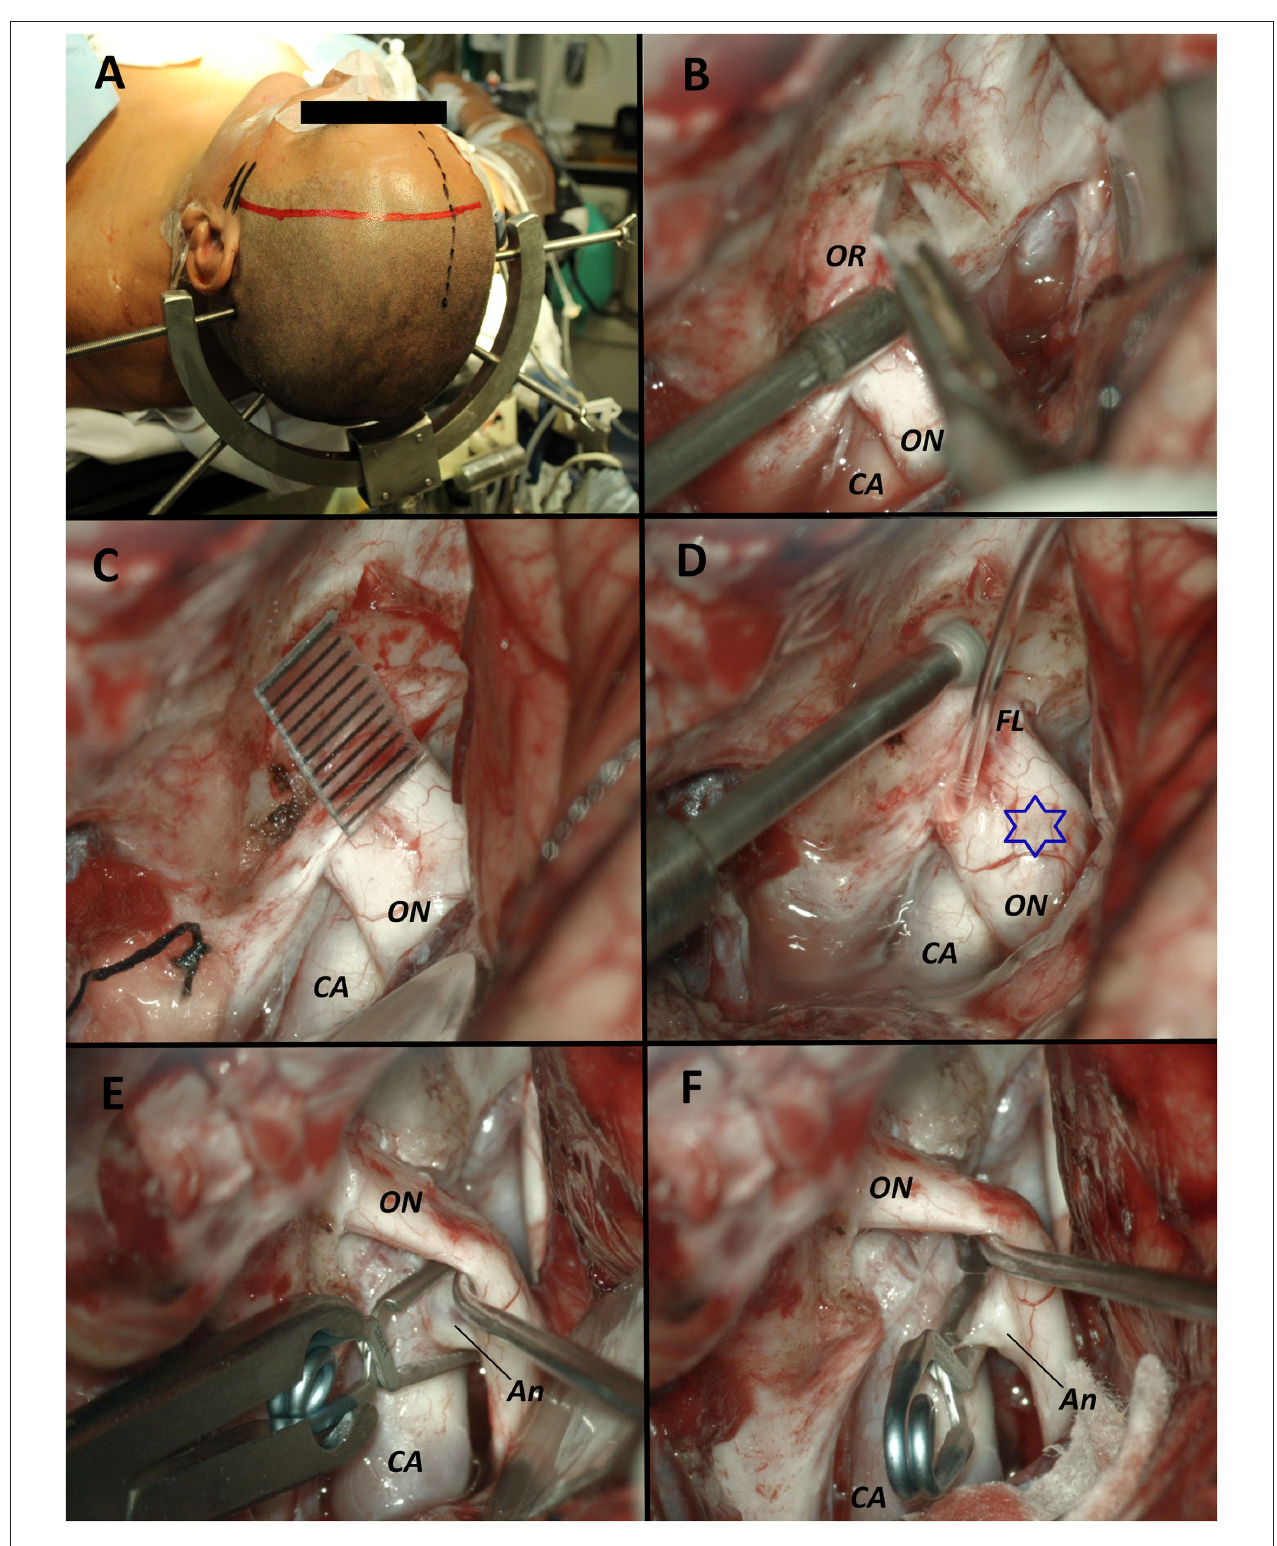
FIGURE 4 | Surgical images from Case 1. (A) Patient position in supine with the head fixed in a 4-pin Sugita head holder and a left curvilinear frontotemporal incision is marked behind the hair line. (B) Exposure of the optic nerve and the carotid artery where we can observe the optic canal roof. A circumferential incision of the dura above the optic canal was made with a blade N ◦ 11. (C) Dissection and removal of the dura is performed with the help of a Penfield microdissector. A caliper marks a